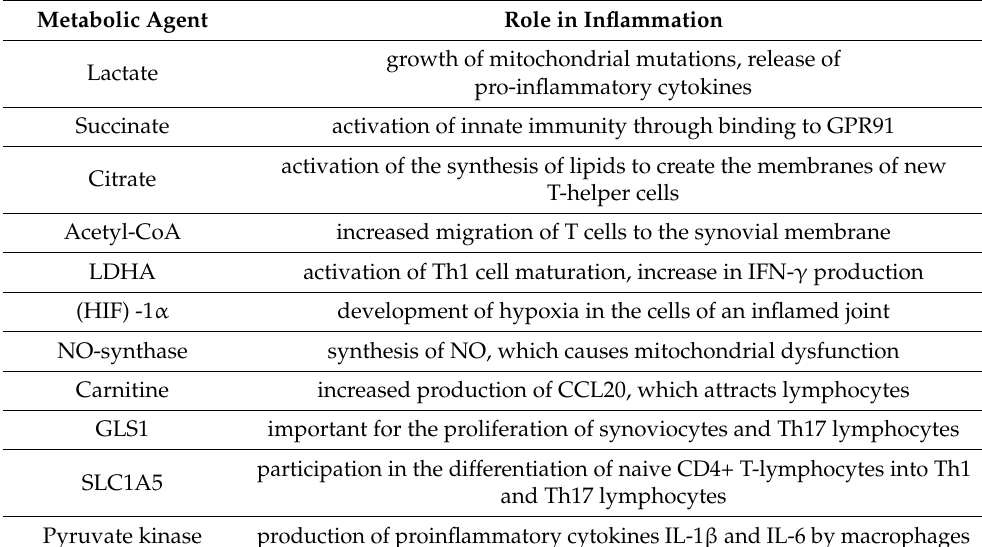
Table 1. Some metabolic agents and their roles in the development of inflammation. Metabolic Agent Role in Inflammation growth of mitochondrial mutations, release of Lactate pro-inflammatory cytokines Succinate activation of innate immunity through binding to GPR91 activation of the synthesis of lipids to create the membranes of new Citrate T-helper